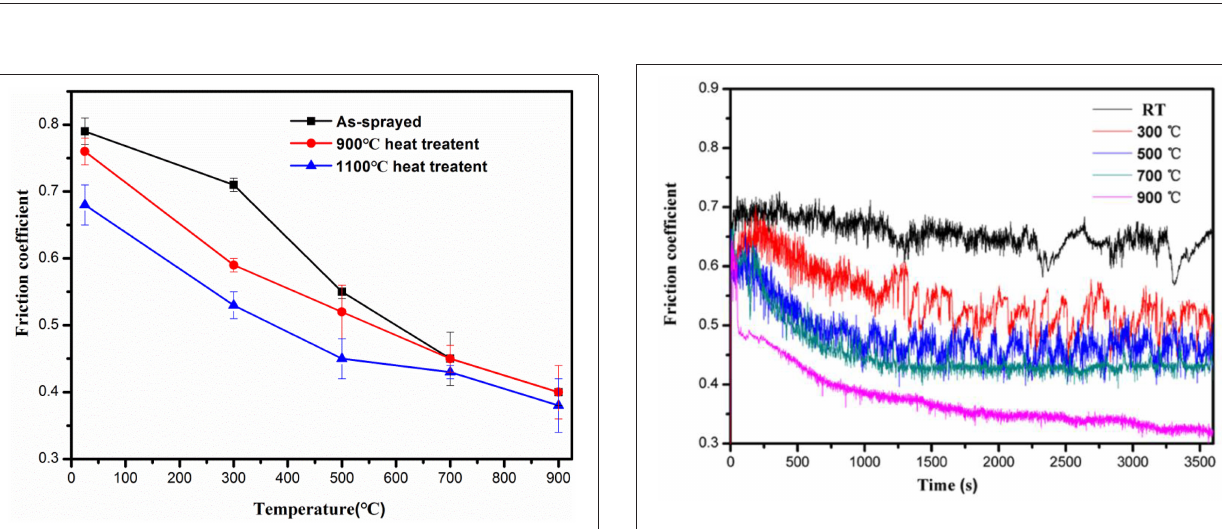
Frontiers in Materials |